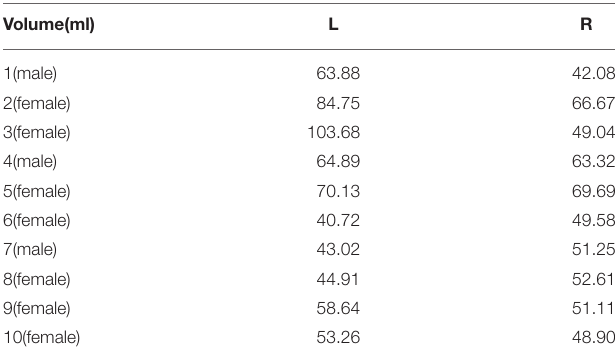
TABLE 2 | Volume studies of the IFOF in 10 individual subjects.